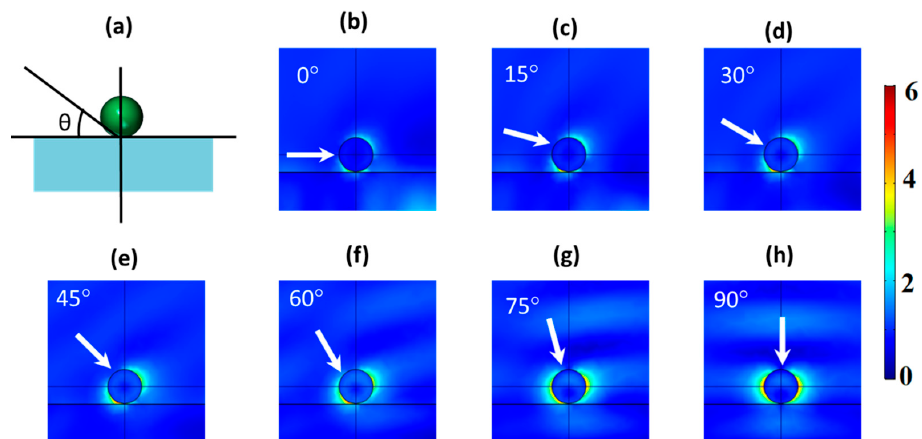
Figure 3. ( a ) A schematic showing how the angle of the incident beam varies with respect to the substrate. ( b – h ) FEM simulations of the scattered field of a Cu 2 O spherical particle with a diameter of 184 nm on a silicon dioxide (SiO 2 ) substrate for different angles of the incident beam with respect to the substrate. The incident wavelength was 632 nm. White arrows label the incident direction.